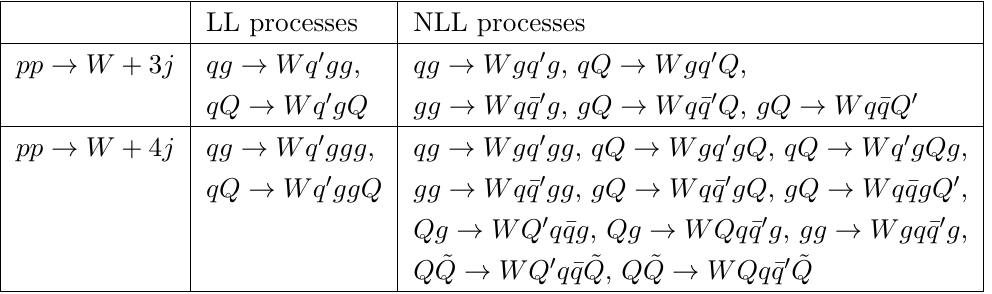
Table 1. A summary of the particle configurations which enter the LL and NLL lines in figure 3 and figure 4. All particles except for the W are listed in rapidity order. q , Q etc. may refer to quarks or anti-quarks. Each process refers to itself and its symmetric counterpart, i.e. qg → Wq 0 gg is shorthand for qg → Wq 0 gg + gq → Wggq 0 . All other subprocesses not listed above are included in the line labelled